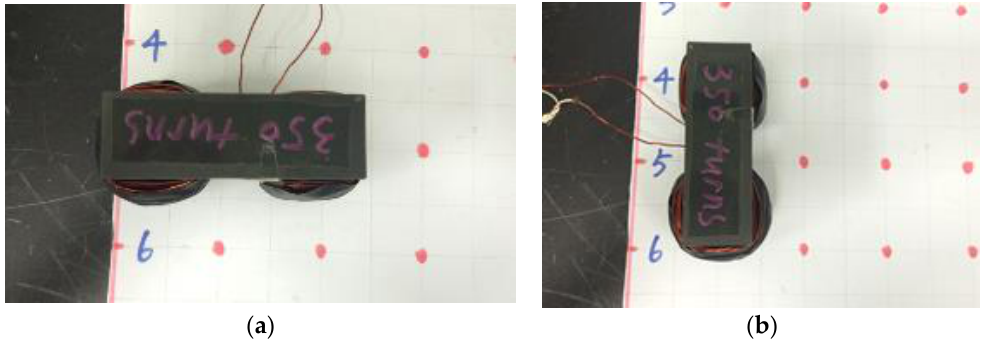
Figure 7. Testing directions. ( a ) Horizontal and ( b ) vertical.